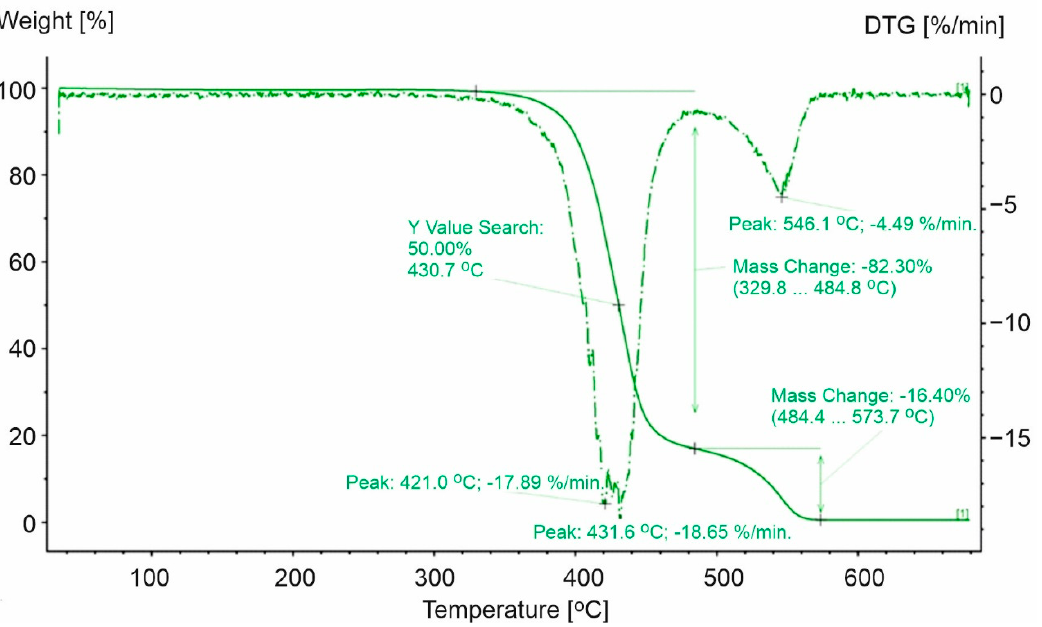
Figure 10. TG and DTG curves for PET ‐ 1. The green line presents TG curve, while the green dot line presents DTG curve.